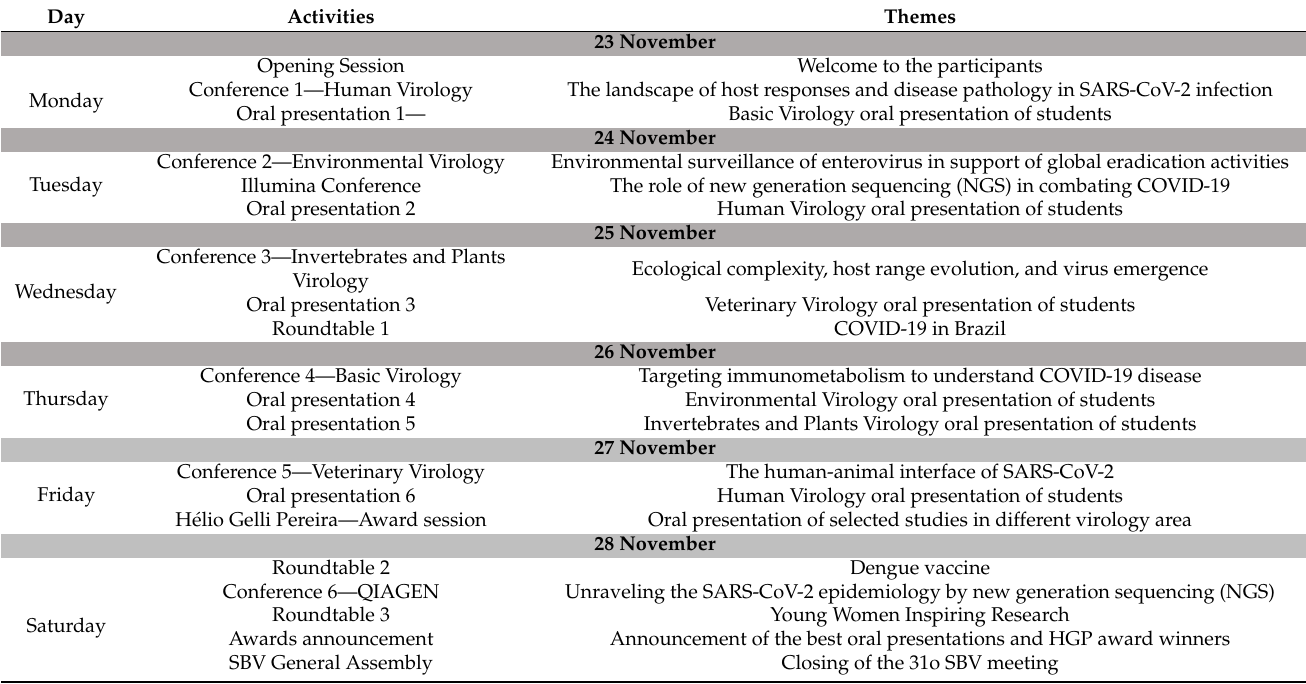
Table 1. Scientific programing schedule of the 31st Brazilian Society for Virology Congress and 15th Mercosur Virology